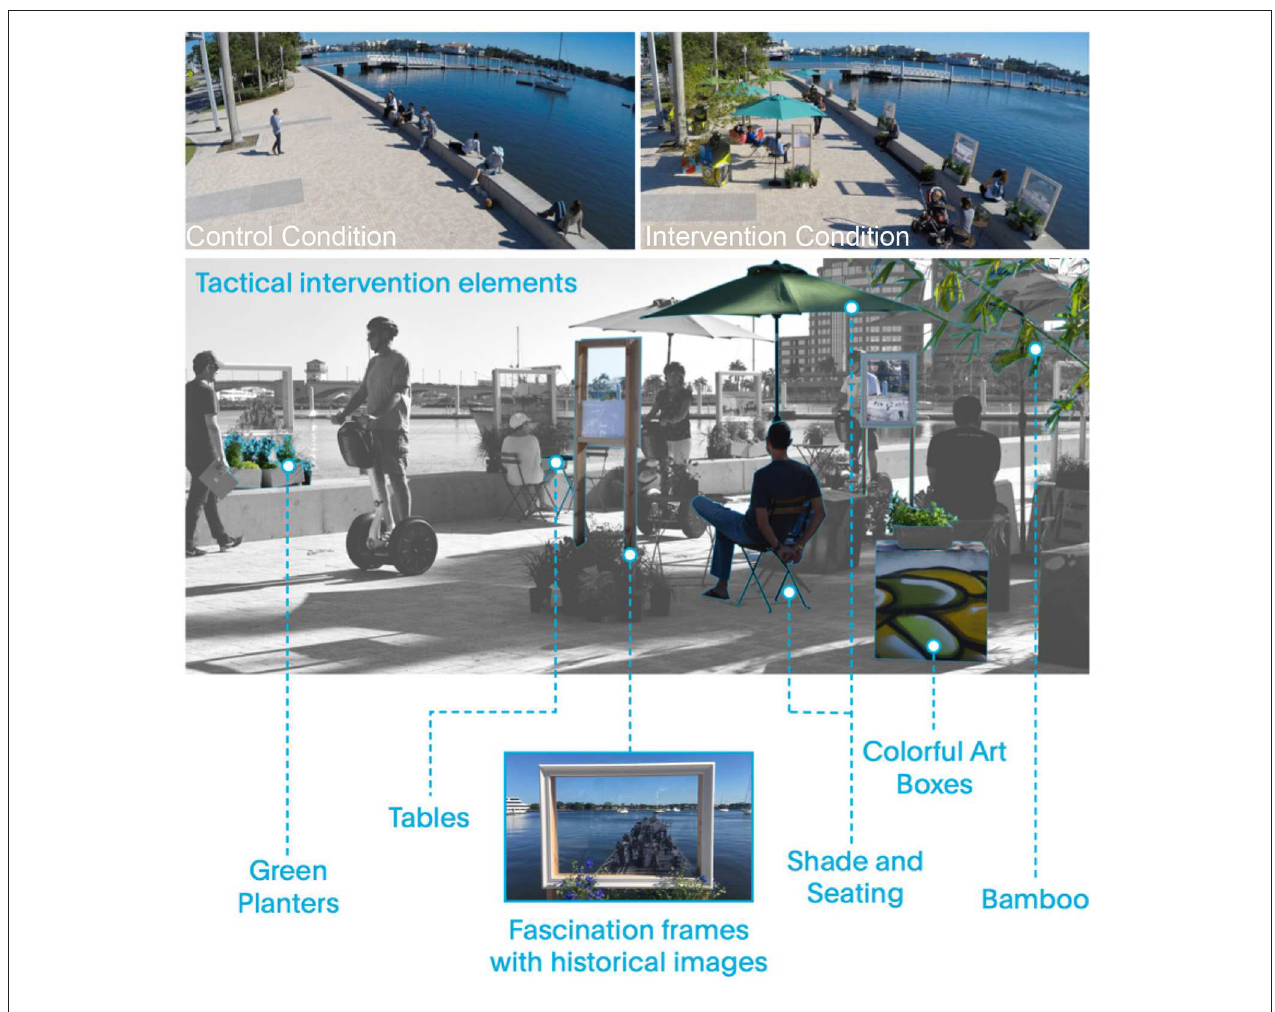
FIGURE 1 | The control and intervention conditions © Happy City.